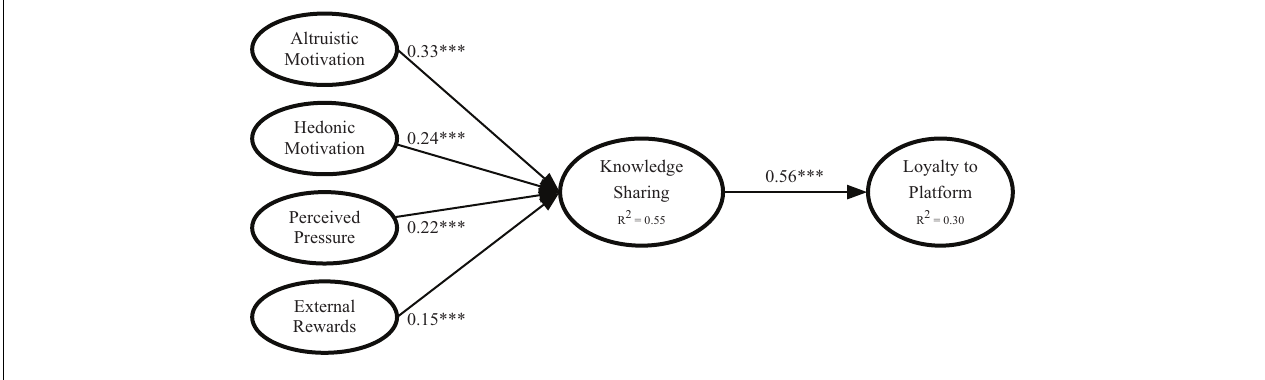
FIGURE 2 | Path coefficients of the structural model. ∗∗∗ Denotes p < 0.01.